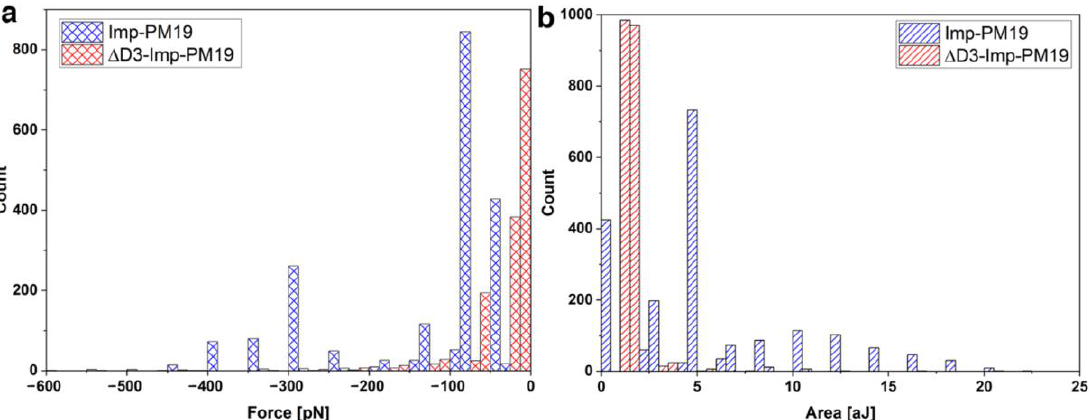
Figure 6. Comparing the obtained interaction parameters with Imp-PM19 (blue bar) and the ∆ D3-Imp-PM19 mutant (red bar) on F-actin rabbit filament. The work of adhesion ( a ) and the most frequently onserved adhesion ( b ) of Imp-PM19 and ∆ D3-Imp-PM19 with F-actin rabbit filament ligands are measured by SMFS. The results are graphically represented. Retraction speed 2 µ m/s, number of curves = 1000, set point of 800